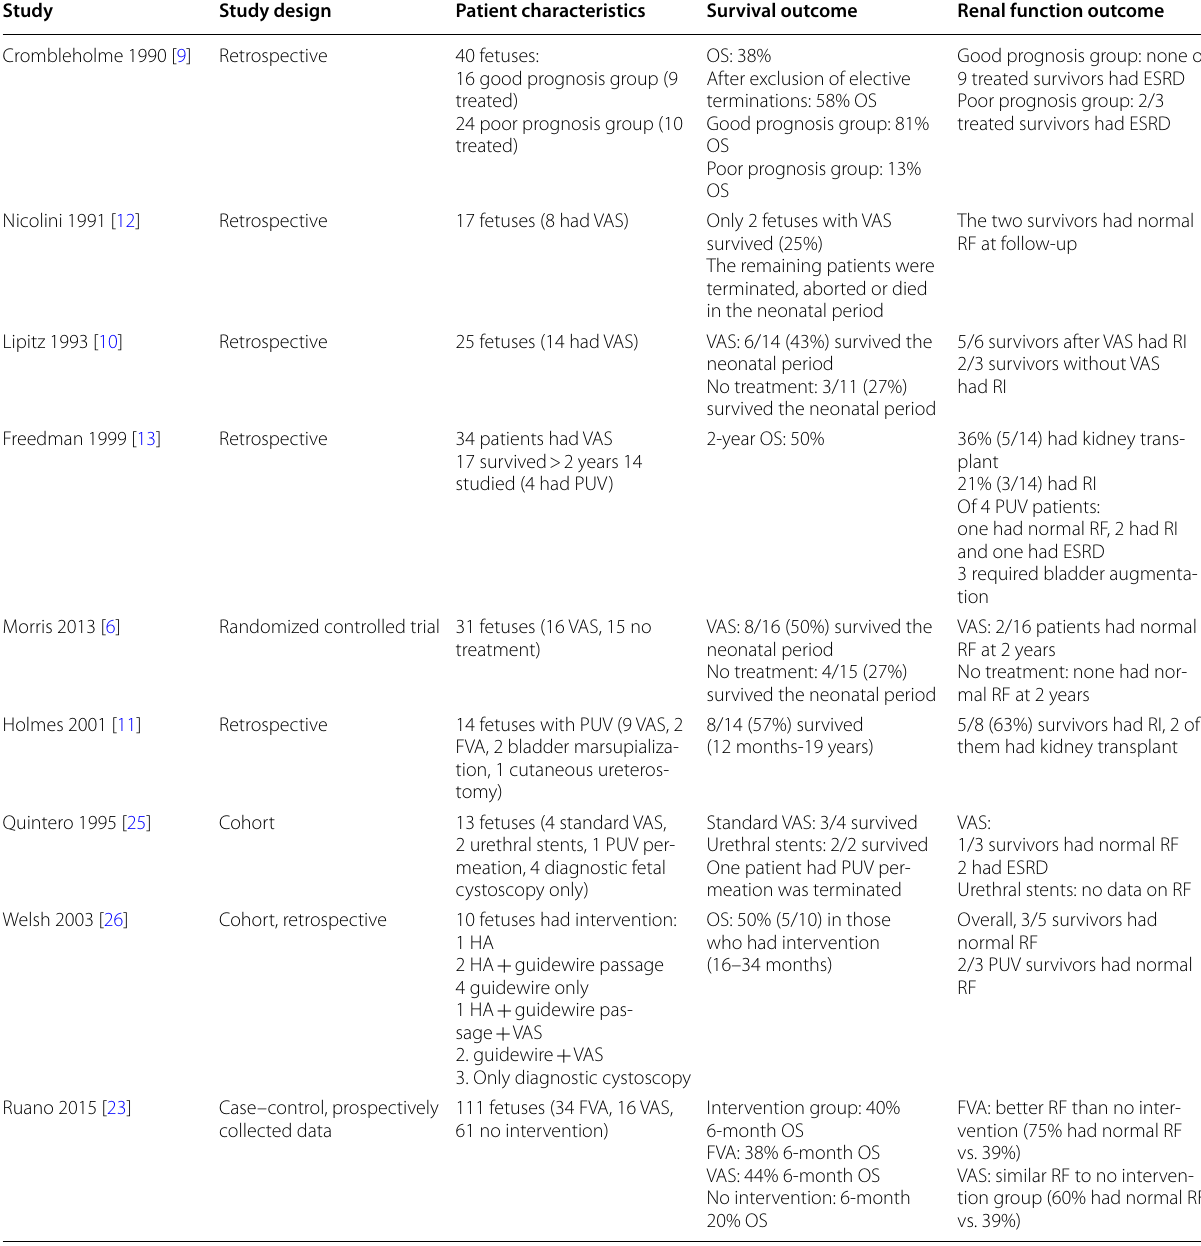
FVA: fetoscopic valve ablation, ESRD: end-stage renal disease, HA: hydroablation, OS: overall survival, PUV: posterior urethral valve, RF: renal function, RI: renal impairment, VAS: vesicoamniotic shunt